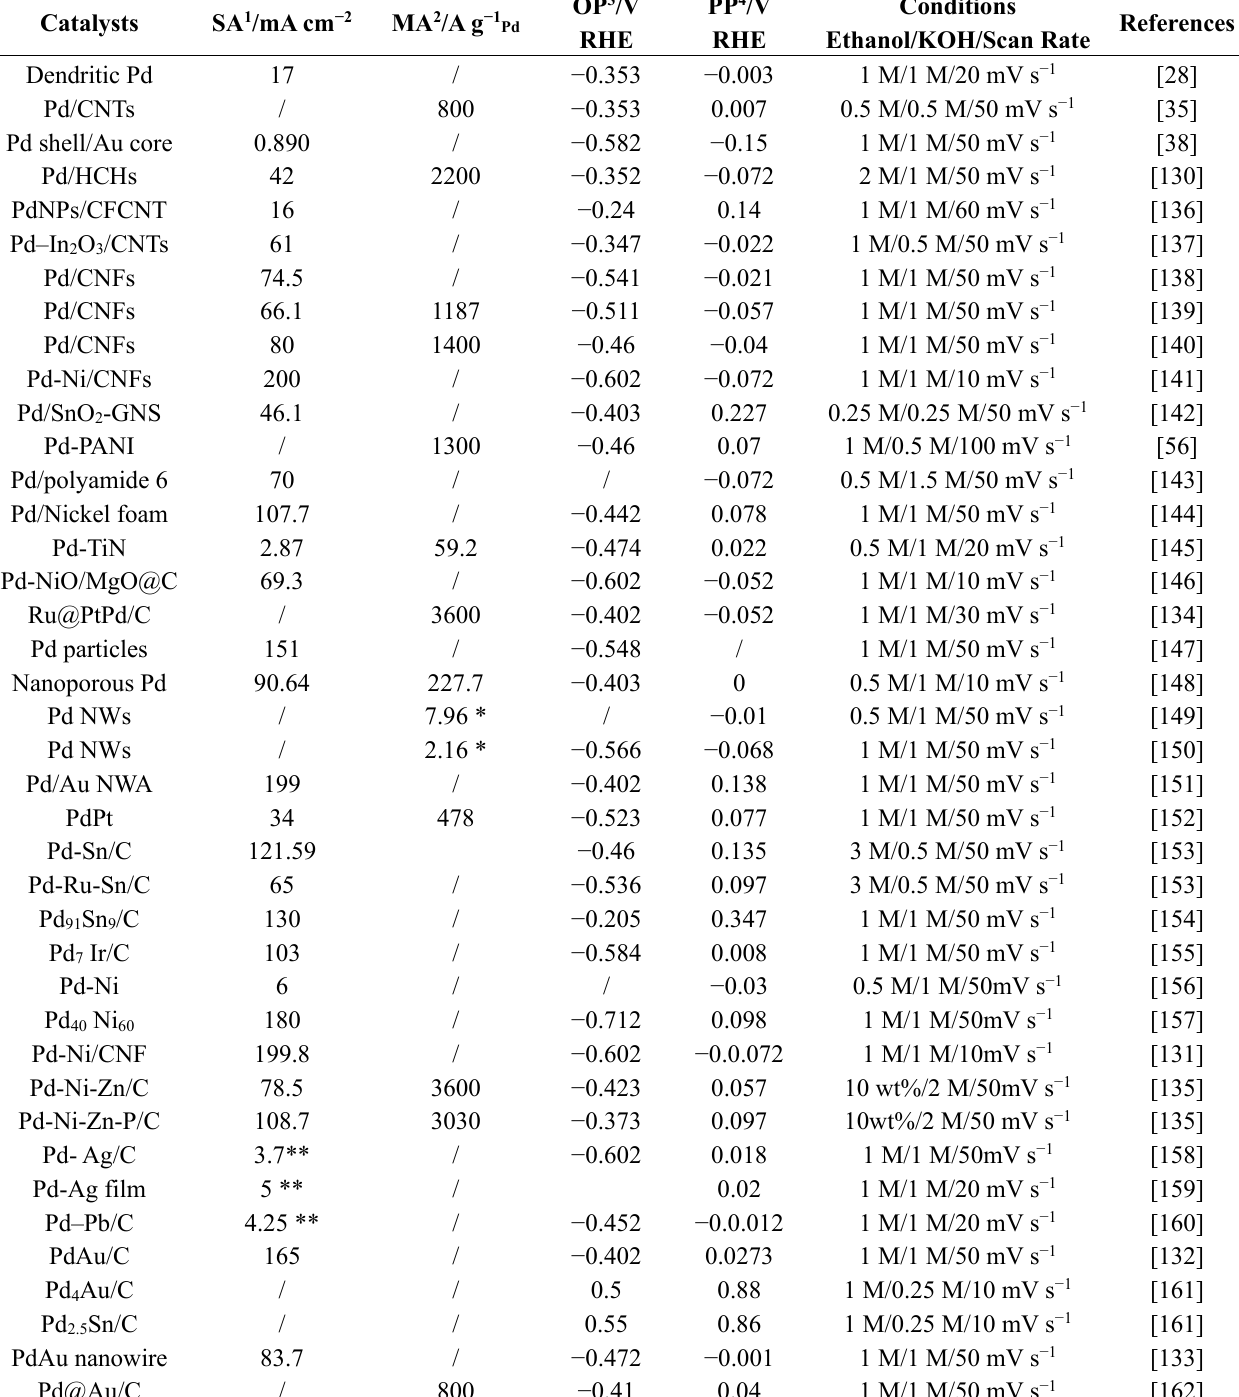
Table 2. Details of the ethanol oxidation on Pd catalysts. (SA: Specific Activity; MA: Mass Activity; OP: Onset Potential and PP: Peak